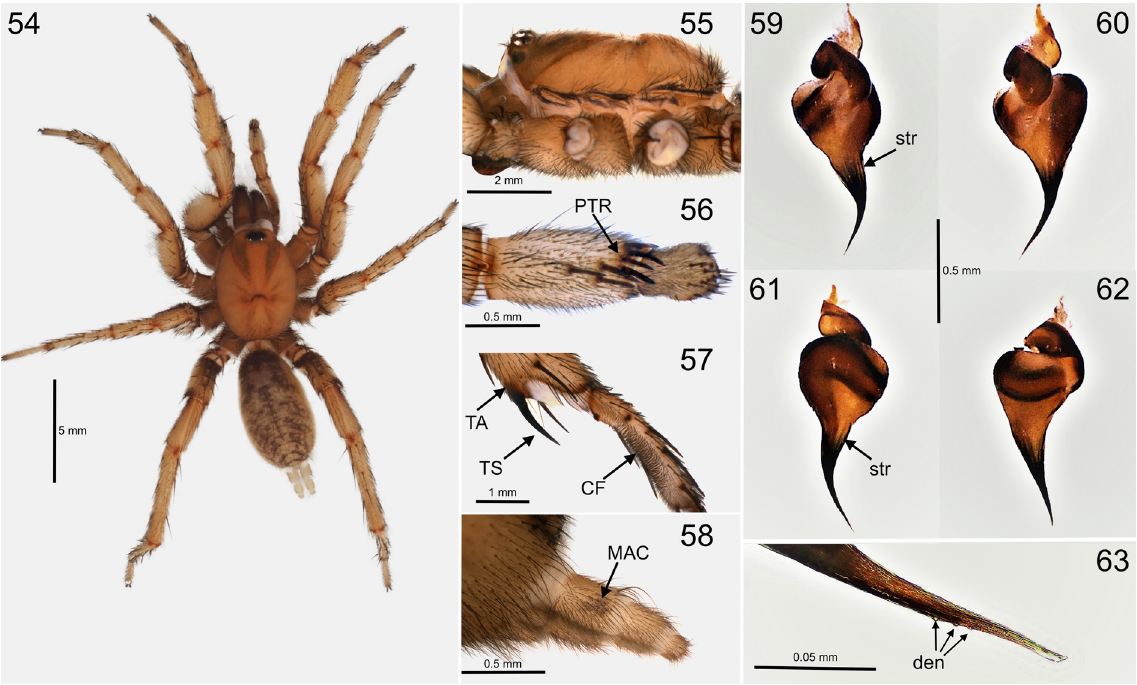
Figs 54–63. Nemesia maltensis sp. nov. holotype, ♂ (TC.004, NHMR). 54 . Dorsal habitus (note distinct dark flanks of cephalic part). 55 . Prosoma in lateral view (note dark margin of the carapace and cephalic part not elevated). 56 . Dorso-distal right palp (note strong development of PTR). 57 . Prolateral left metatarsus and distal tibia leg I (note CF with dense brush of short bristles, short TA and smoothly curved TS). 58 . Spinnerets, lateral view showing macula (MAC) on external proximal article of PLS. 59–63 . Right palpal organ in four different positions rotated clock-wise by 90°. 59 . Ventral view. 60 . Prolateral view. 61 . Dorsal view. 62 . Retrolateral view. 63 . Embolus tip at high magnification, note short row of tiny denticles (den) and bevelled